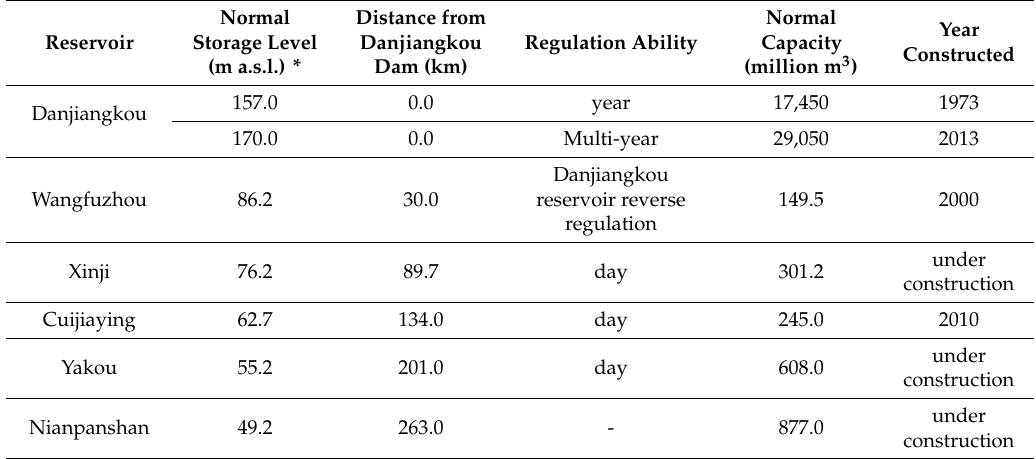
Table 1. Information of the cascade reservoirs in the middle reaches of Hanjiang